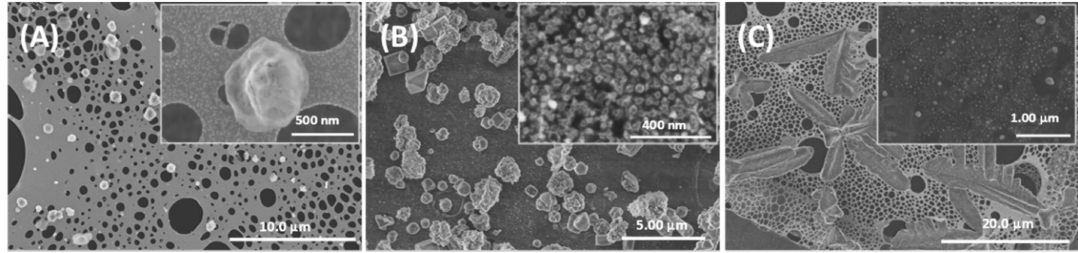
Figure 9. SEM images of the particles in gas emissions, where ( A ), ( B ) and ( C ) are G#1, G#2, and